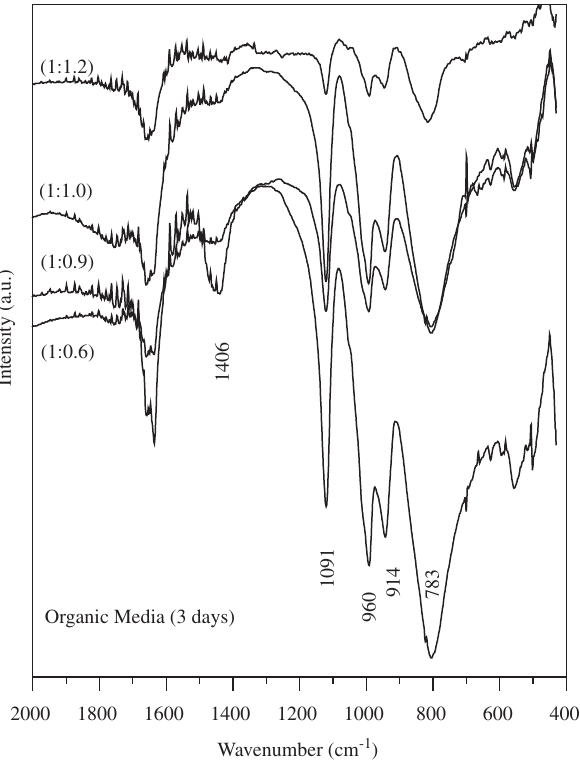
Figure 2. Infrared spectra of the materials obtained through the ion exchange of the (NH ) P W O .13H O salt after 3 days in contact with variable amounts 4 6 2 18 62 2 of acid resin in ethanol media. The numbers in parenthesis represent the (salt: resin) weight